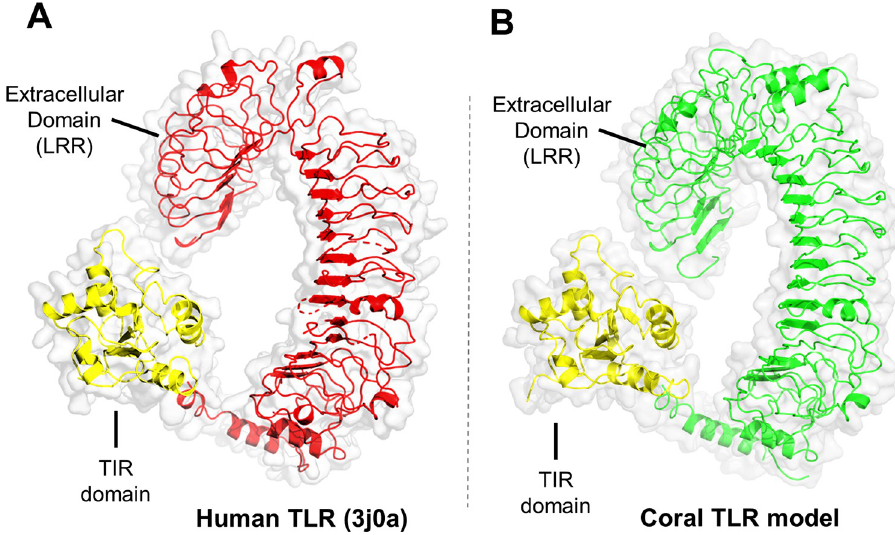
Fig 8. Coral TLR homology model based on the full-length TLR5 structure model with pdb id 3j0a LRR: Leucine rich repeats. (A) Structure reconstruction of the full-length human TLR5 protein (3j0a). (B) Homology model of P . damicornis 9200 protein using the human TLR5 structure reconstruction model as a